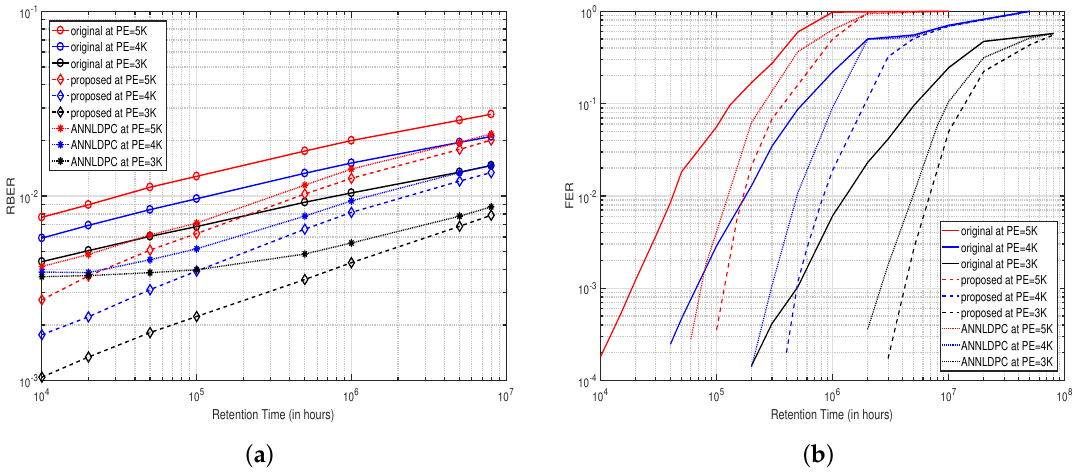
Figure 9. ( a ) Comparison of the raw bit error rate (RBER) performance of NAND flash memory with and without ANNAEC scheme versus data retention time at s = 1. ( b ) Comparison of the frame error rate (FER) performance of low-density parity-check (LDPC) coded NAND flash memory with and without the ANNAEC scheme versus data retention time at s =